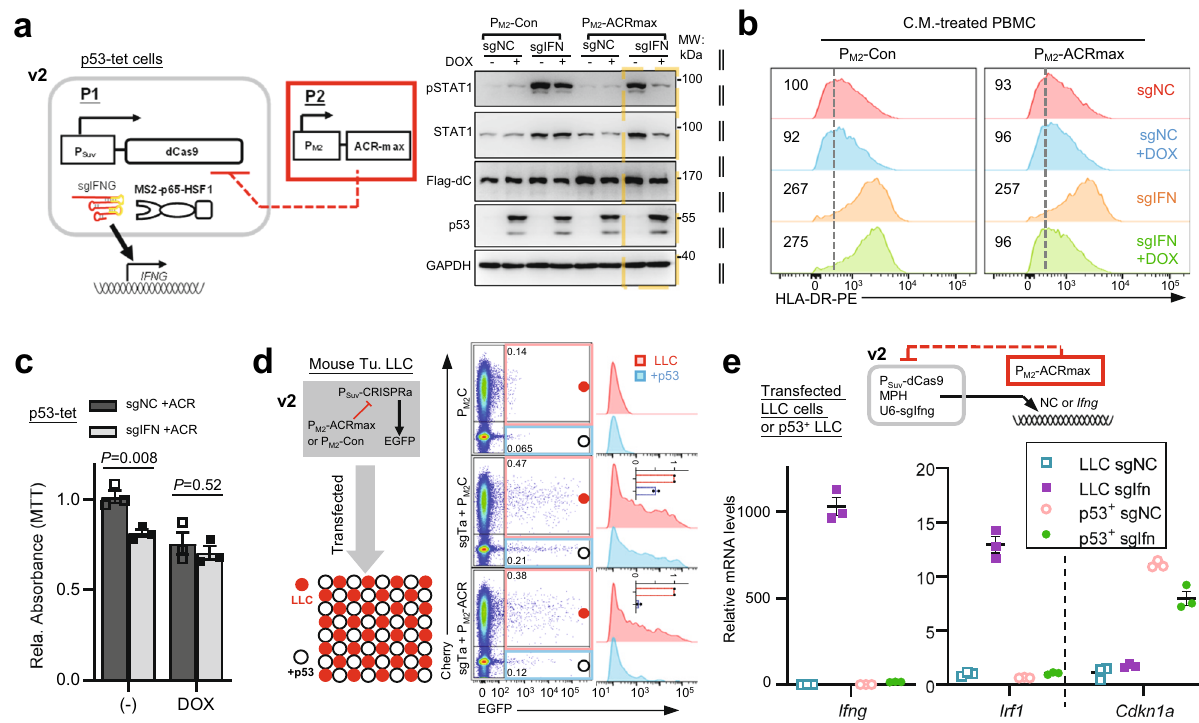
Fig. 5 An improved P Suv /P M2 AND-NOT logic circuit (v2) rewires p53-de fi cient tumor cells to produce IFN γ . a – c In a , the p53-tet H1299 cells (±10 ng/ ml DOX) were introduced with the circuit shown on the left ( “ v2 ” ). The P Suv -driven CRISPRa is programmed to activate transcription of endogenous IFNG